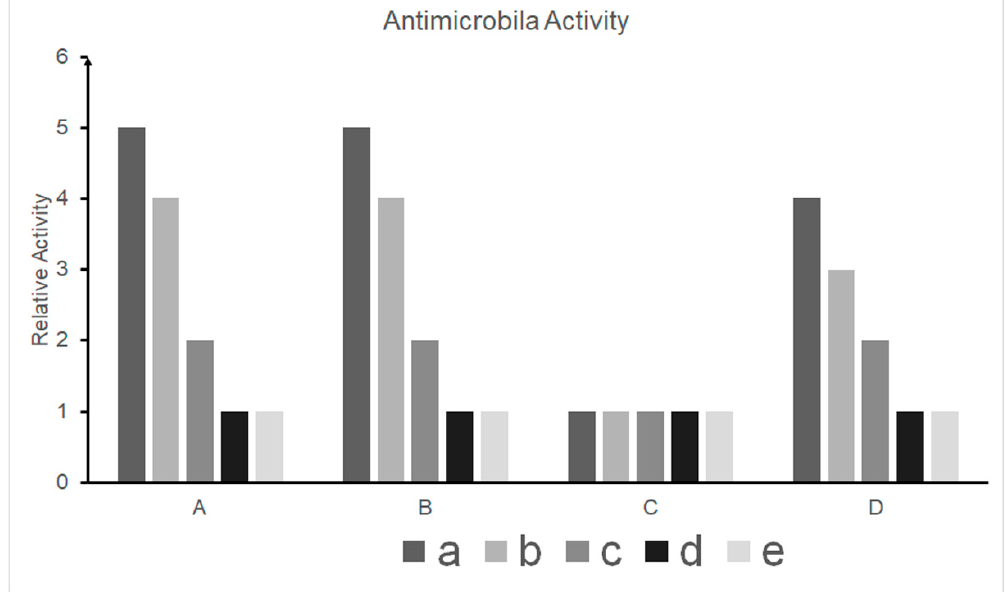
Figure 4. Antimicrobial activity of Hamp1 and Hamp2. ( A ) Biological activity testing of Hamp1 against Streptococcus iniae FP5228; from a to d, the concentration of hepcidin was 0.60 mg/L, 0.48 mg/L, 0.36 mg/L, and 0.24 mg/L, respectively. With decreasing concentration, the antimicrobial effect was reduced. ( B ) Biological activity test of Hamp2 against Streptococcus iniae FP5228; from a to d, the concentration of hepcidin is 0.56mg/L, 0.42mg/L, 0.30mg/L, and 0.20mg/L, respectively. The antimicrobial effect decreased with decreasing concentration. ( C ) Hamp1 antimicrobial activity against Pseudomonas aeruginosa ; from a to d, the concentration of Hamp1 was 0.20 mg/L, 0.40 mg/L, 0.80 mg/L, and 1.00 mg/L, respectively. No bioactive effect variation with increasing concentration of Hamp1 was observed. ( D ) Hamp2 peptide from E. coli showed antibacterial activity against Pseudomonas aeruginosa ; the inhibition zone shrank with decreasing peptide concentration. From d to a, the concentration was 0.20 mg/L, 0.40 mg/L, 0.80 mg/L, and 1.00 mg/L, respectively. e. the negative control: buffer used for dissolving the peptide.